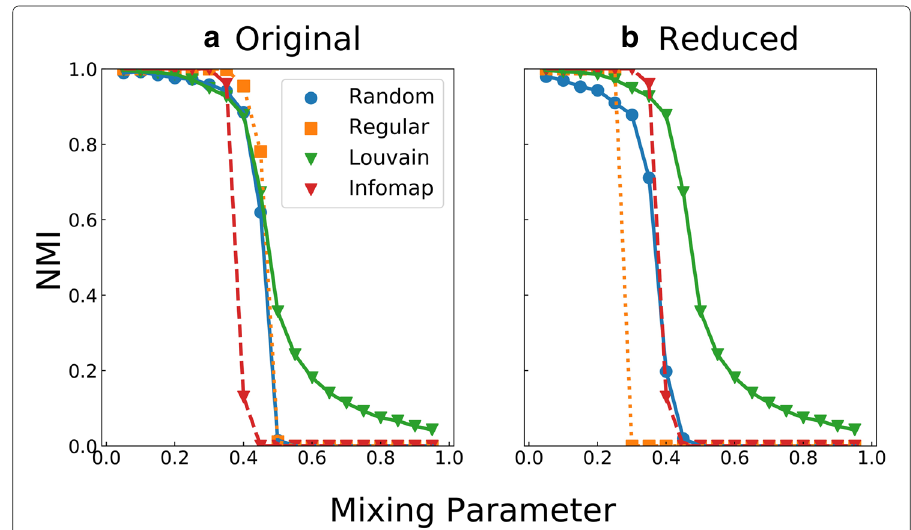
Fig. 4 Performance of the community detection algorithm on the Girvan-Newman (GN) benchmark graph. We plot measure values of the normalized mutual information (NMI) as a function of the mixing parameter μ of the model. a Results of the original version of the algorithm with both starting conditions; b Performance of the reduced version of the algorithm. Both of these are compared with Louvain and